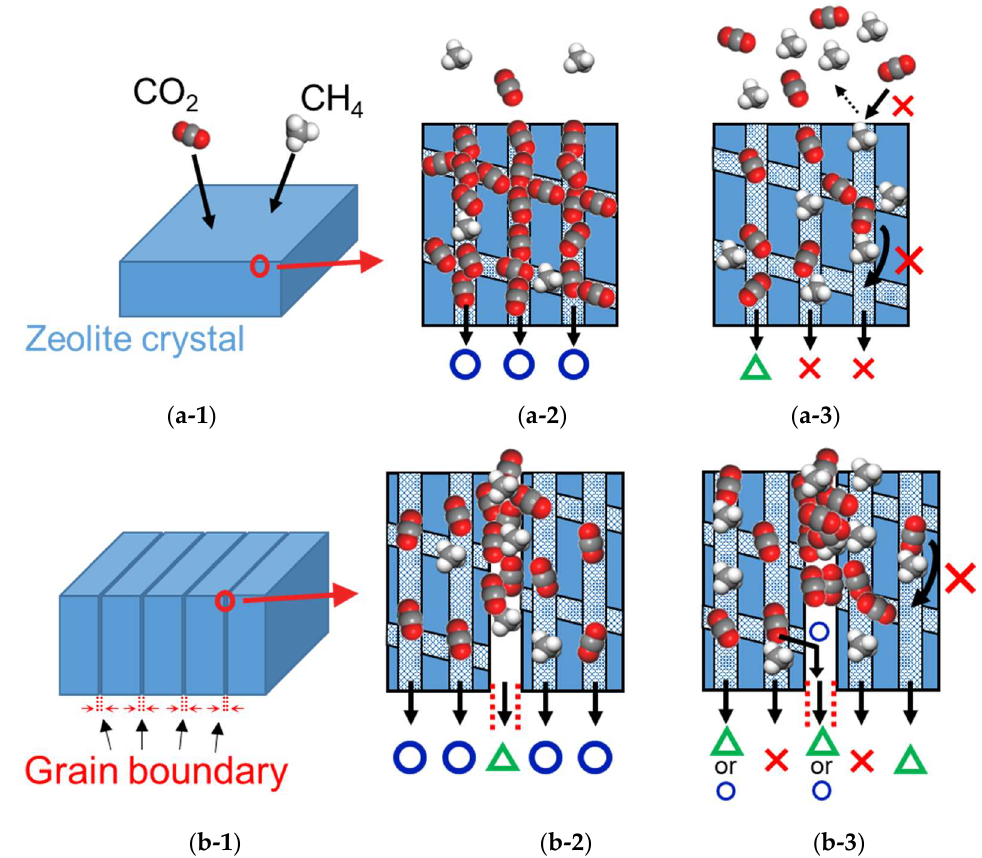
Figure 9. The illustration of the mechanism of effect in permeability by grain boundaries at low and high pressure. ( a ) Perfectly crystalline, ( b ) polycrystalline. ( 1 ) Schematic of membrane model, ( 2 ) low pressure, ( 3 ) high pressure, The symbols of the circle, the triangle, and the cross mean the high CO 2 selectivity, low CO 2 selectivity, and no selectivity, respectively.